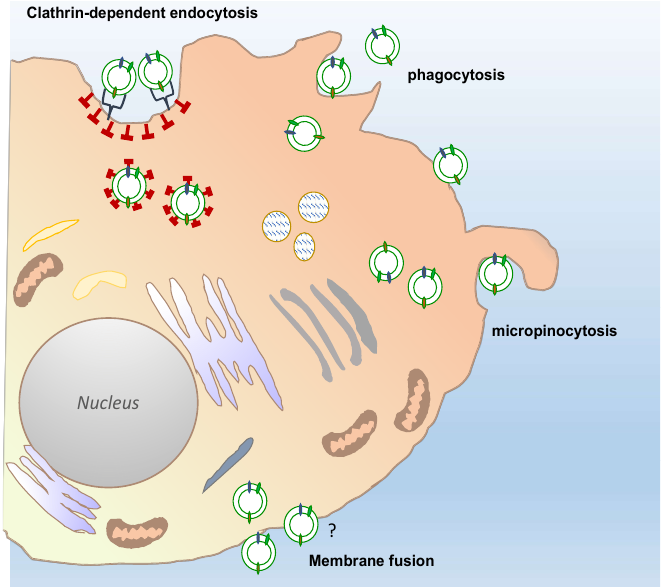
Figure 4. Possible different routes of plant-derived vesicles uptake into a target cell. Recipient cells can receive plant-derived vesicles through different, well described uptake mechanisms: Phagocytosis, macropinocytosis, and clathrin-dependent endocytosis. The passive membrane fusion is also shown in the figure. The question mark indicates that this mechanisms remains still to be elucidated for PDV uptake, although described for many types of EVs.